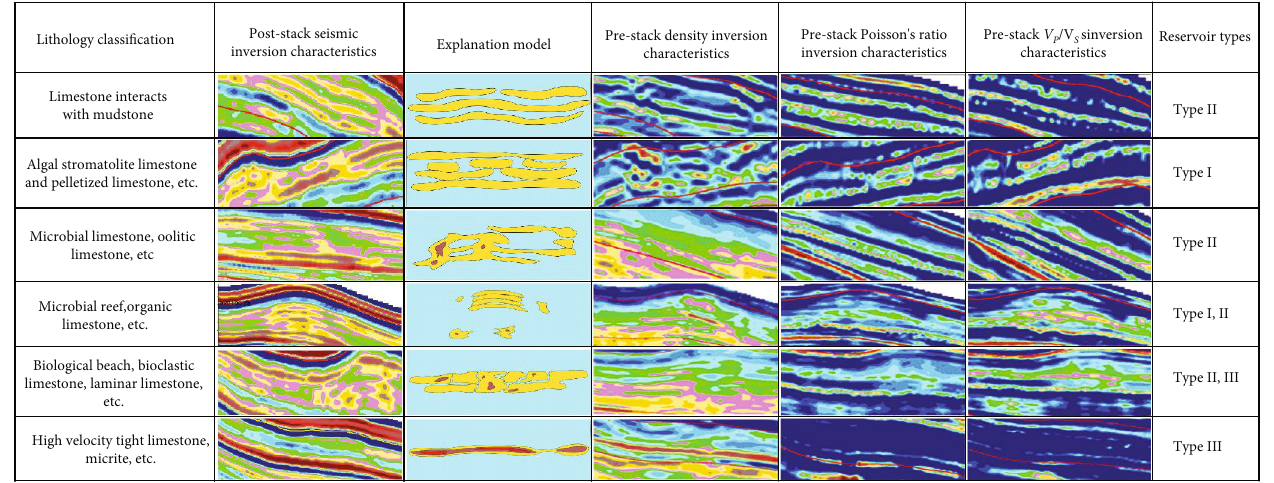
Lithology classification Explanation model